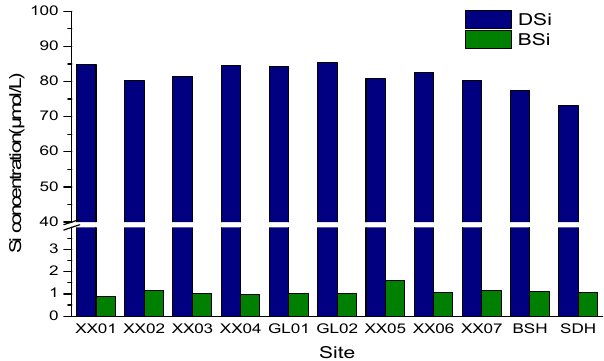
Figure 2. DSi and BSi concentrations at each site (mean value, N = 23 at each site).